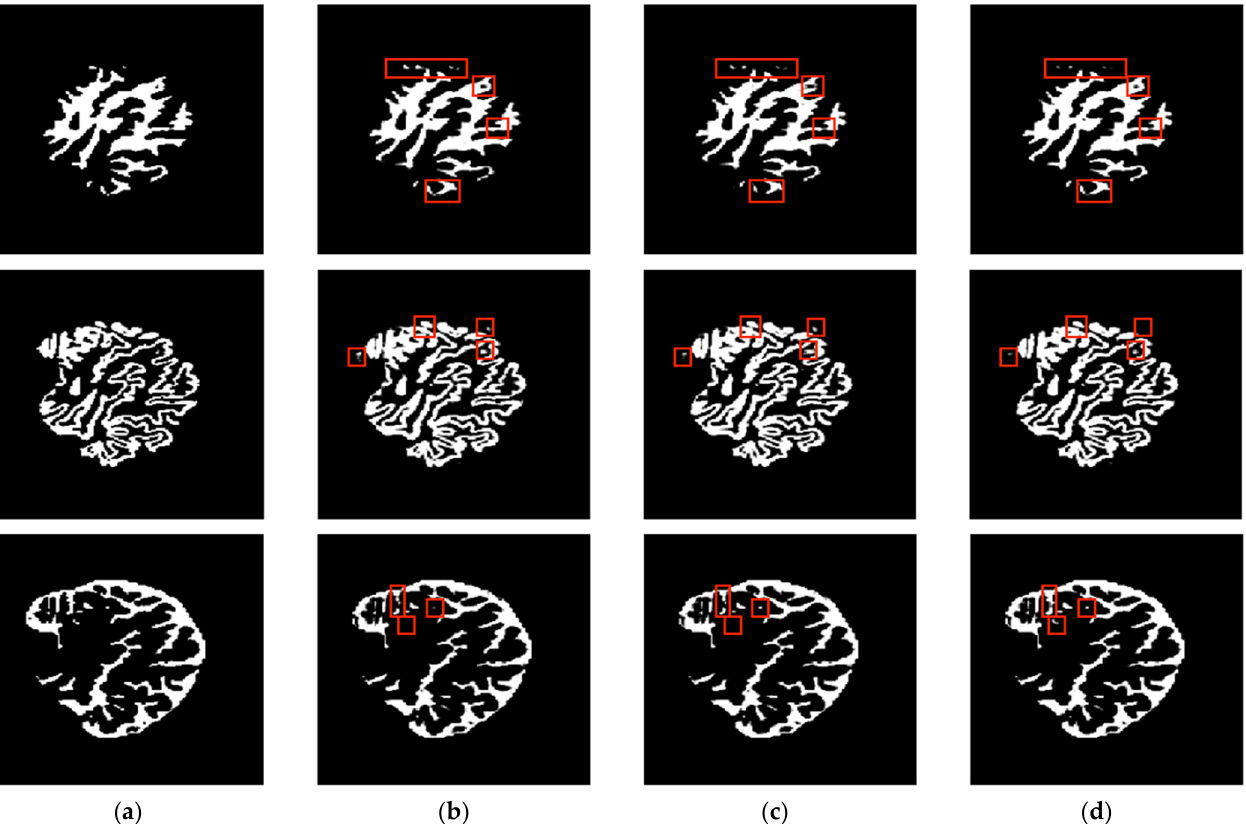
Figure 9. Illustration of segmentation results for sagittal plane for existing methods and SIP-UNet for WM, GM, and CSF (top to bottom): ( a ) ground truth (binary map), segmented binary maps generated by ( b ) single-slice input UNet, ( c ) multi-slice input UNet, and ( d ) proposed SIP-UNet.